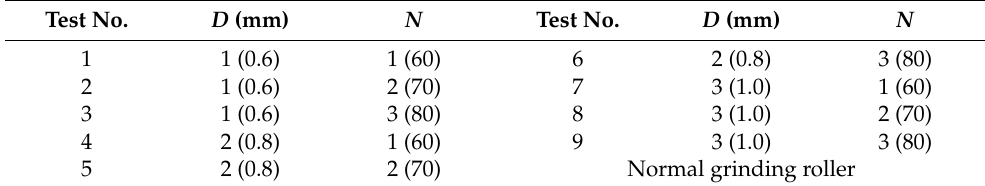
Table 2. Factor, level, and test number.